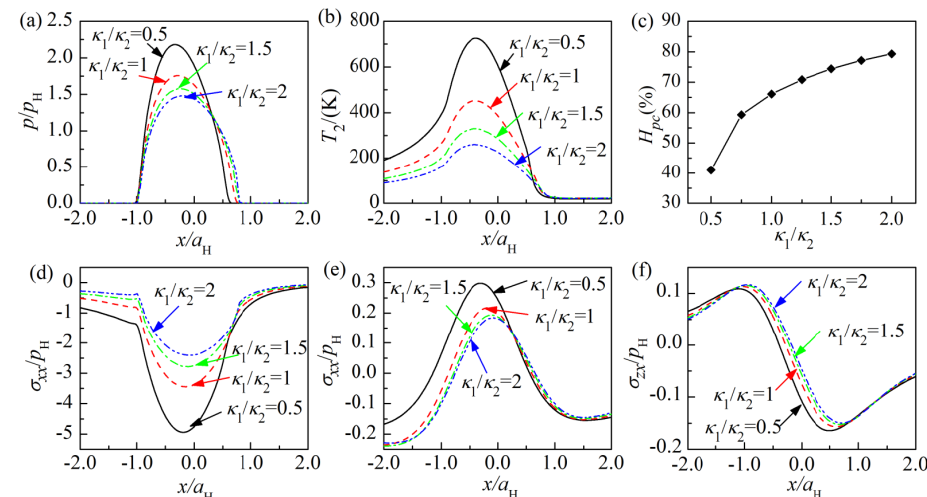
Figure 8. Effect of the coating thermal conductivity κ 1 on: ( a ) contact pressure along x axis, ( b ) surface temperature rise along x axis, ( c ) frictional heat partition coefficient, ( d ) σ xx on the surface, ( e ) σ xx at the base of the coating, ( f ) σ zx on the interface.